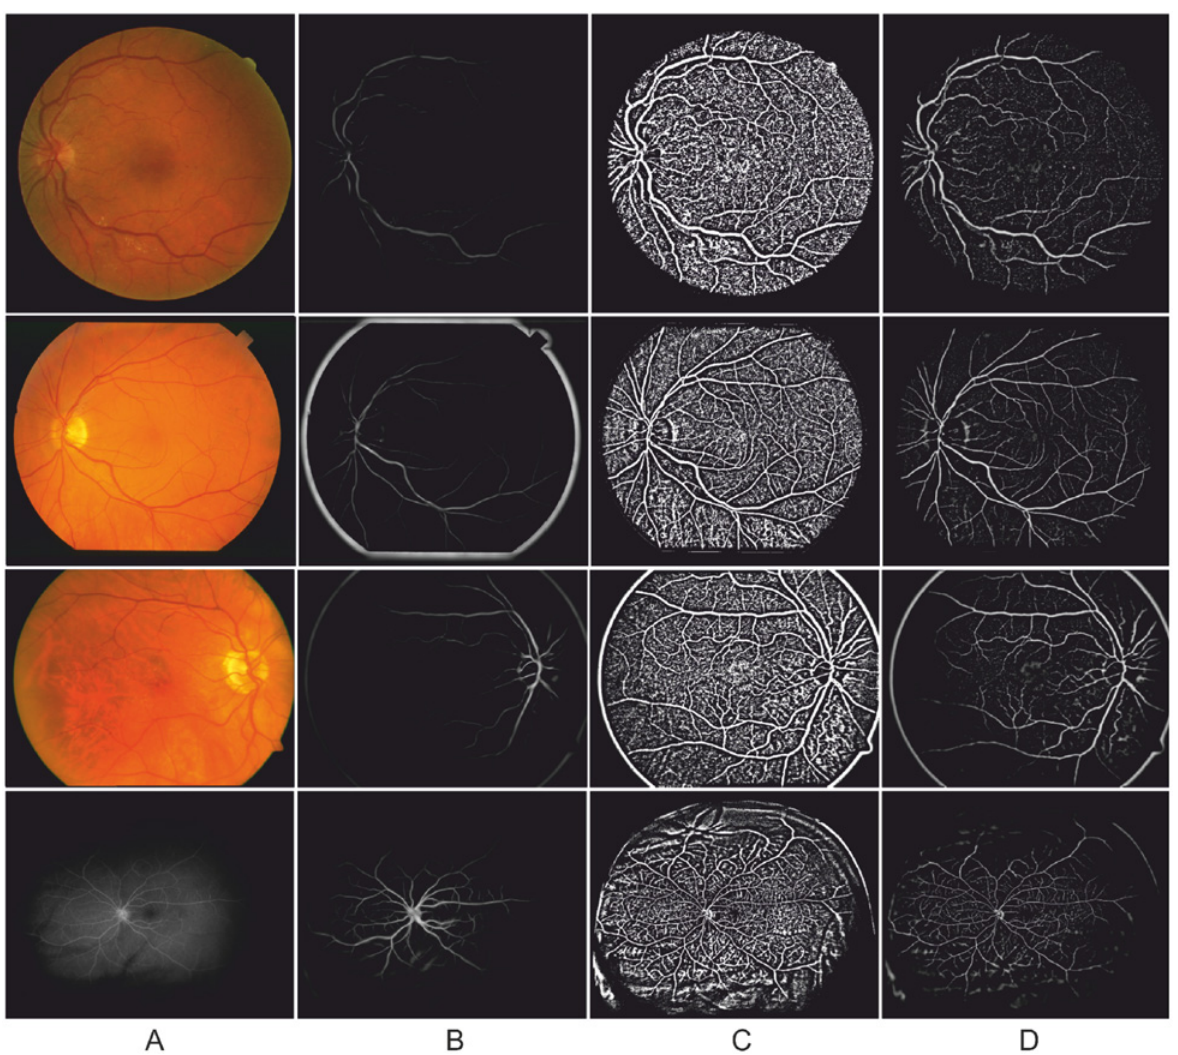
Fig 3. Enhancement results produced by an eigenvalue-based method [28], a wavelet-based method [17] and the local phase method, respectively. An image was randomly chosen from each of the four datasets. From top to bottom: DRIVE, STARE, ARIA, and VAMPIRE. (A) Example images. (B) Eigenvalue-based enhancement results. (C) Wavelet-based enhancement results. (D) Local phase based enhancement